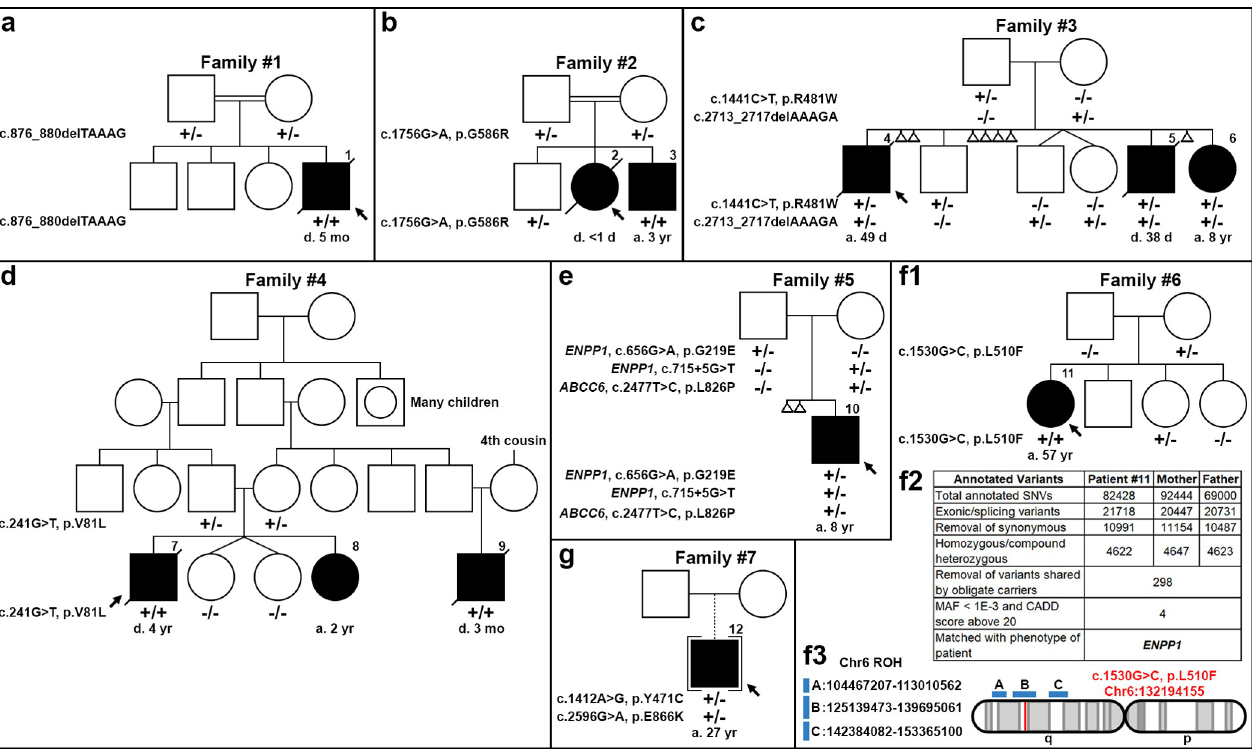
Fig 1. Nuclear pedigrees of families with a diagnosis of GACI or PXE. (a-e), GACI families #1–5; ( f-g ), PXE families #6–7. Patient identifier (#1 through 12) was placed above their symbol. The variants identified in the ENPP1 and ABCC6 genes in the individual family members are indicated below each individual: +/+, variants present in both alleles; +/-, heterozygous; -/-, homozygous for the wild-type allele. Unless otherwise noted, all variants were found in ENPP1 . The stepwise bioinformatic filtering of exome sequencing data for variant detection in family #6 was narrowed to ENPP1 (panel f2). The uniparental inheritance of the c.1530G > C (p.L510F) variant in ENPP1 in patient #11 was shown in one Run of Homozygosity (ROH; blue region) on Chromosome 6 inherited from her mother (panel f3). d, died; a, alive.